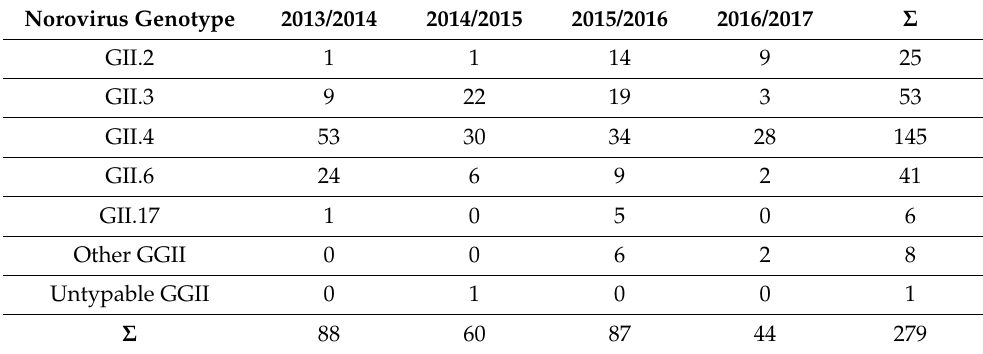
Table 3. Norovirus GII genotypes by season in children < 5 years, Leipzig University Hospital, October 2013–September